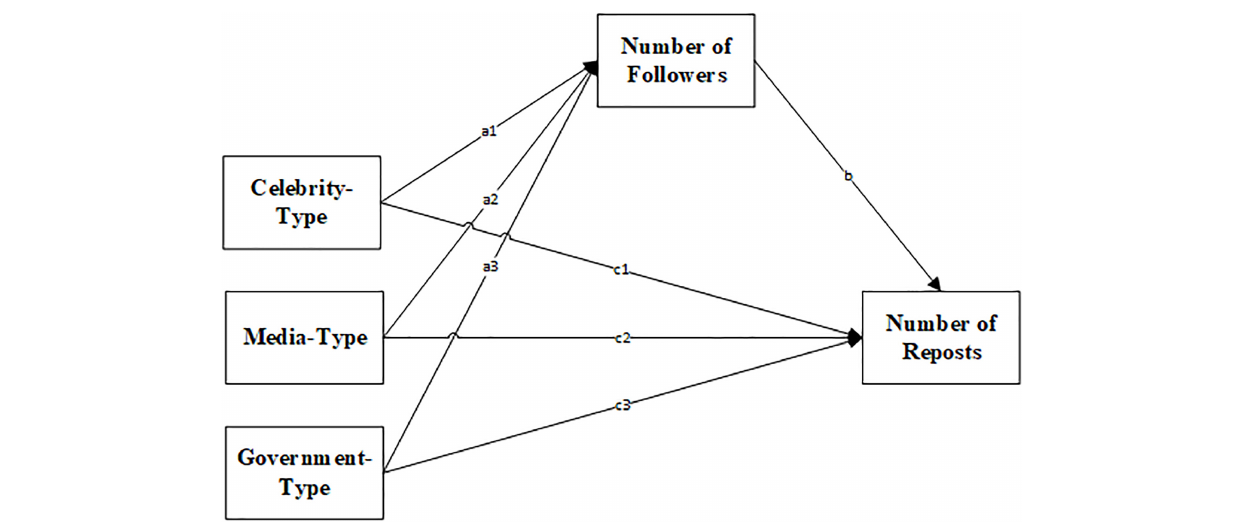
FIGURE 1 | The mediation mode. a × b represents the value of the indirect effect (which is the value of ind_eff in Table 2 ), c represents the value of the direct effect (which is the value of dir_eff in Table 2 ). For example, in Sample 1, the indirect effect a1 × b of the celebrity-type account on the number of reposts is ind_eff = 0.457 and is significant at the 1% level, and the direct effect c1 is dir_eff = 0.054 and is not significant.